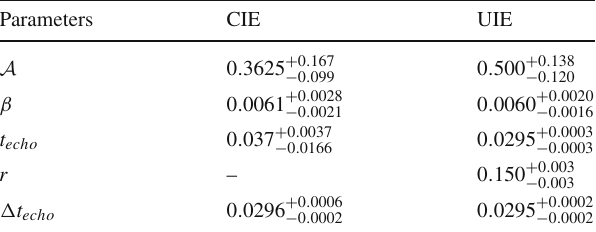
Table 2 The summary of the statistics of a parameter estimation run with a 3 σ error bar Parameters